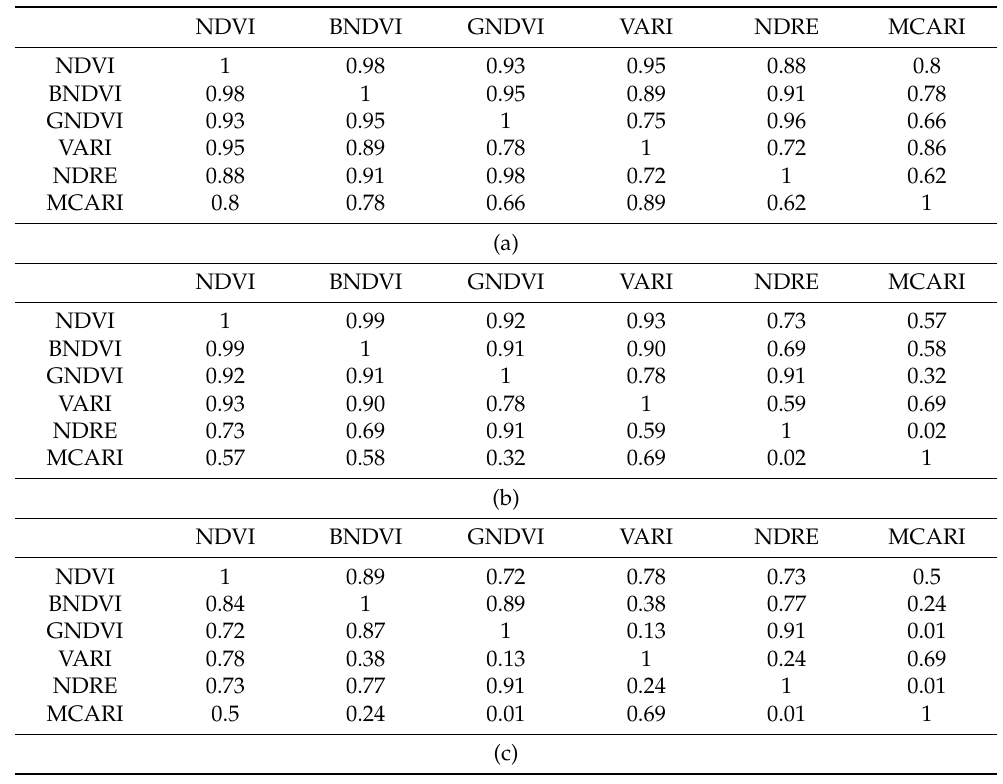
Table 2. Correlation matrix of six vegetation indices of paddy field in 8 July 2020 (early